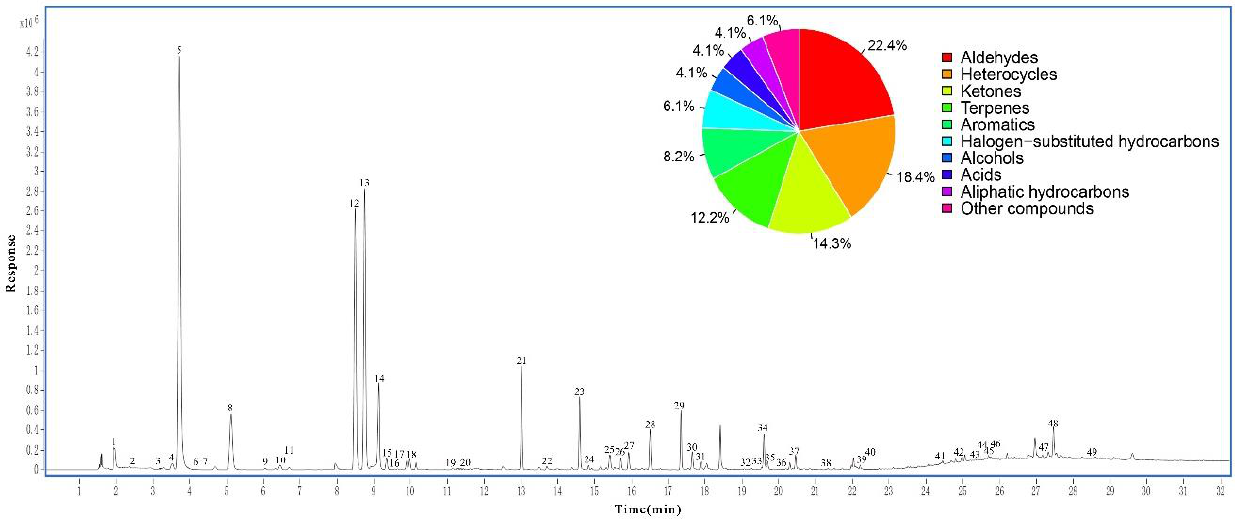
Figure 2. The total ion chromatogram (TIC) of burdock root (BR) sample.